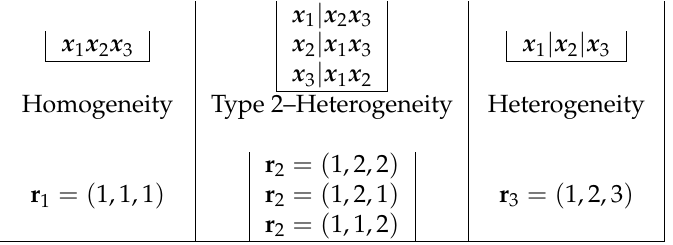
Figure 1. Clustering structure and different heterogeneity structures with k = 3